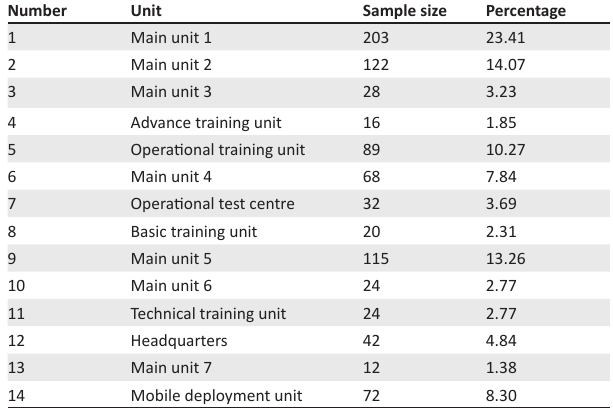
TABLE 1: Unit representation.